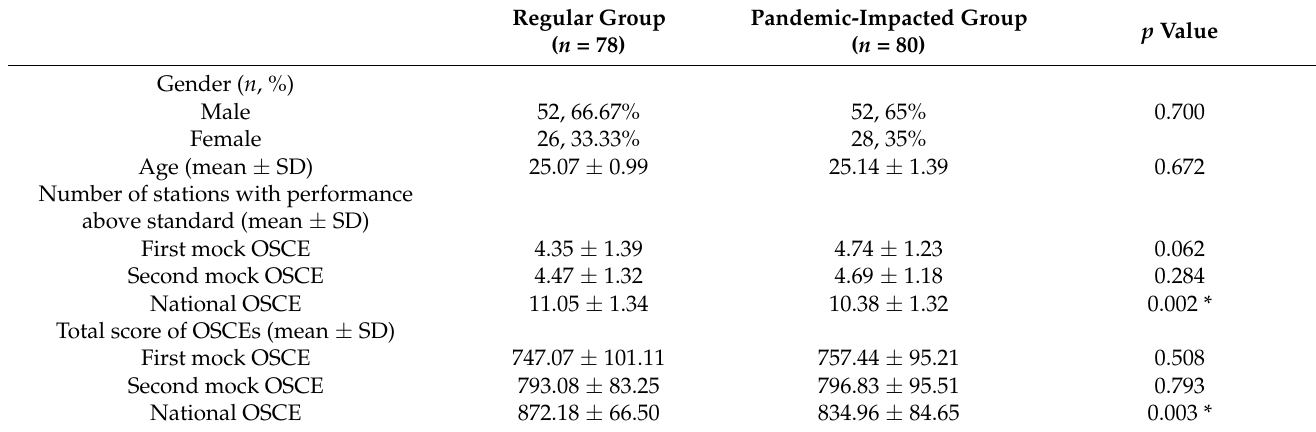
Table 1. Descriptive statistics. * Results were considered significant by p <